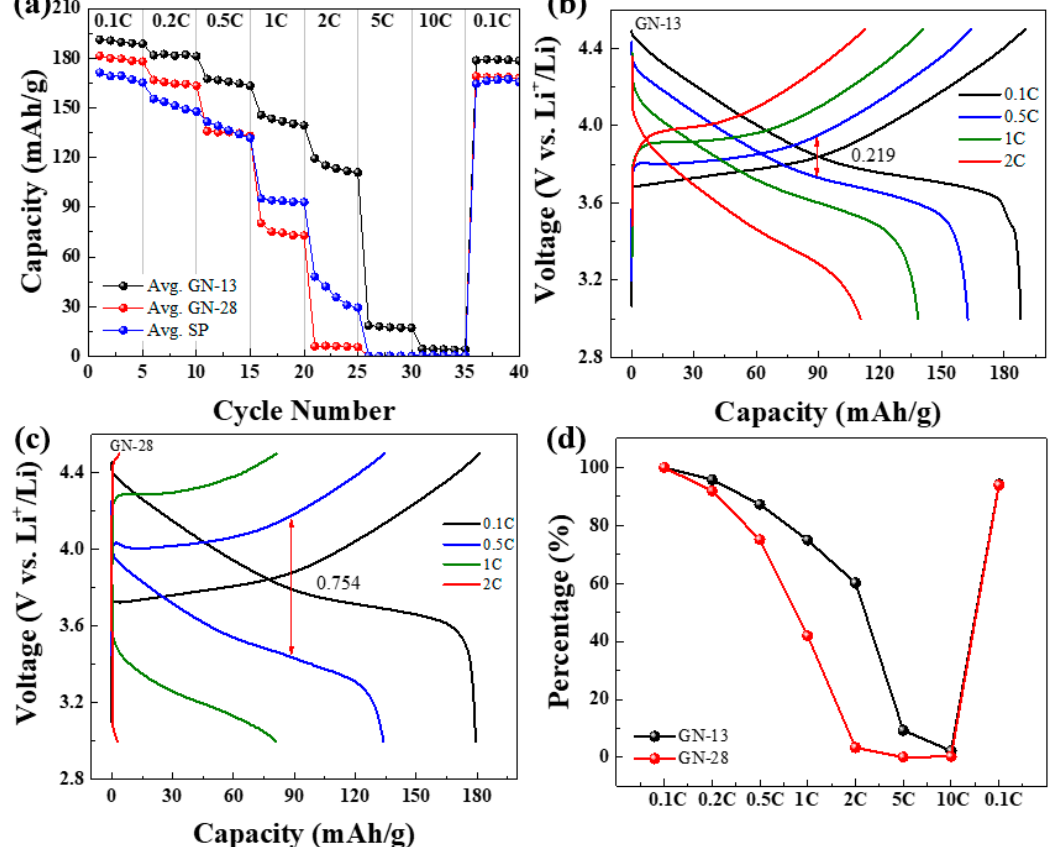
Figure 6. Electrochemical properties of NCM: ( a ) C-rate tests, charge/discharge curves of NCM at ff erent C-rates of ( b ) GN-13 and ( c ) GN-28. ( d ) Retentions of di ff erent different C-rates of ( b ) GN-13 and ( c ) GN-28. ( d ) Retentions of different C-rates. di